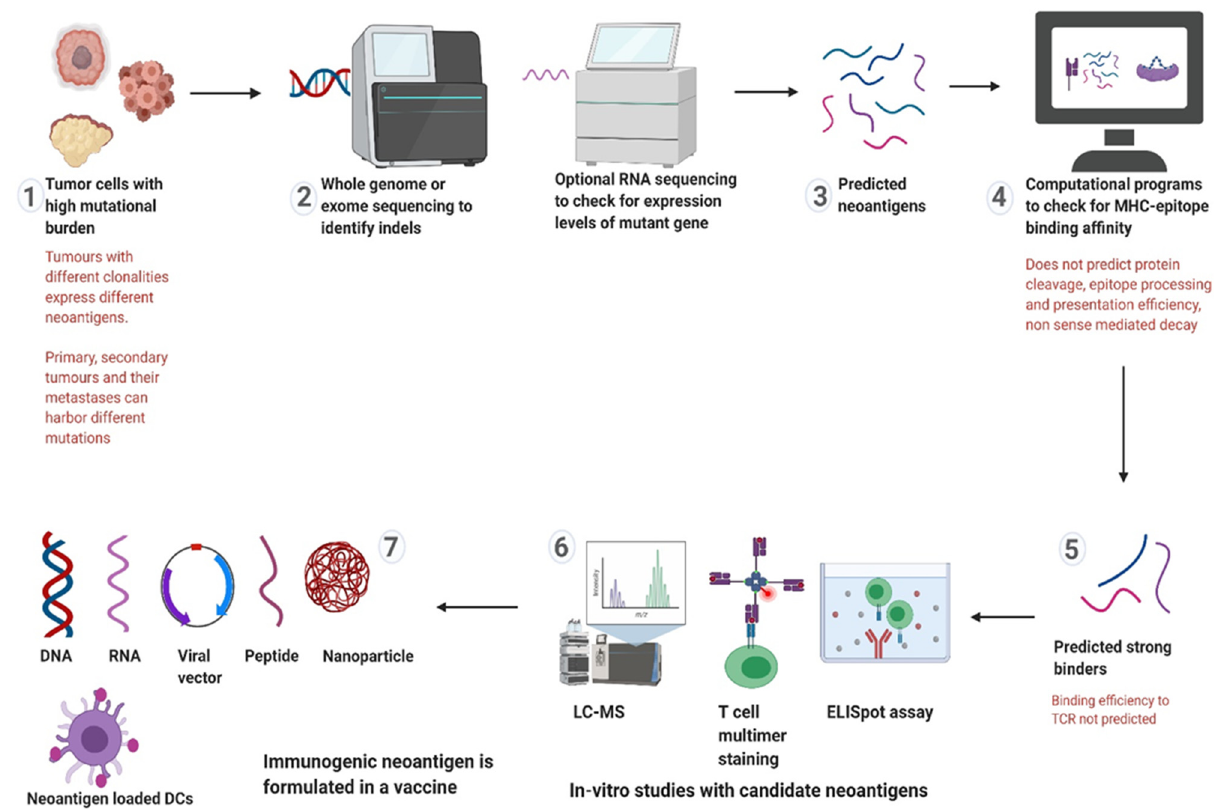
Figure 3. Schematic view of the different steps of developing a neoantigen targeting therapy and the challenges encountered in each step. 1–2 Whole exome sequencing from resected tumours or adenomas identifies indels; 3–4 The predicted neoantigens are assessed for HLA binding affinity through machine-learning methods; 5–6 Predicted strong binders are tested for immunogenicity in-vitro through biochemical and immunological assays; 7 Immunogenic neoantigen can be formulated in different forms before being administered in the patient. Abbreviations—TCR: T cell receptor, LC-MS: Liquid chromatography-Mass spectrometry.